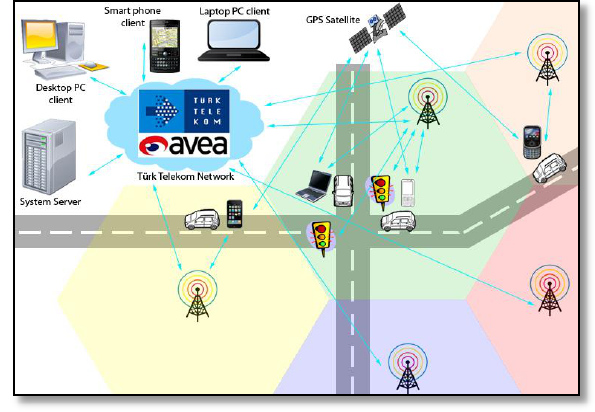
Figure 2: Illustration of smart city. Source: Turktelekomint